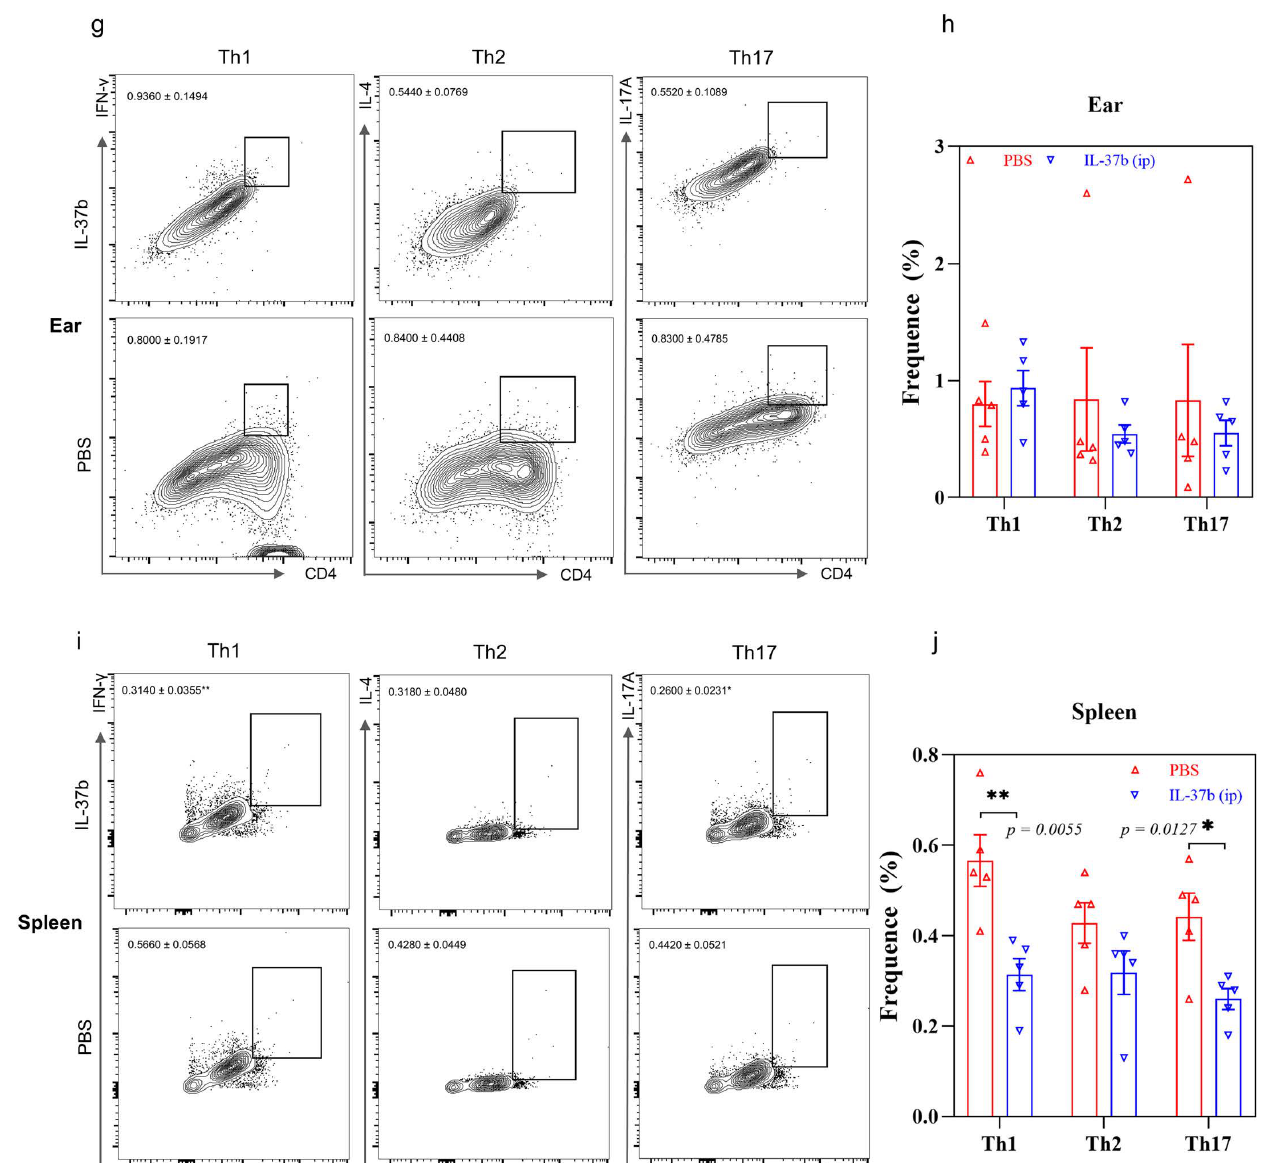
Figure 6. Effects of IL-37b injection on AD. ( a ) AD murine model schedule; ( b ) ear swelling, skin moisture and scratching times; ( c ) flow cytometry analysis of basophil, eosinophil and mast cell population in ear tissue; ( d ) quantitative analysis of result in ( c ); ( e ) flow cytometry analysis of basophil, eosinophil and mast cell population in the spleen; ( f ) quantitative analysis of result in ( e ); ( g ) flow cytometry analysis Th1, Th2 and Th17 cell population in ear tissue; ( h ) quantitative analysis of result in ( g ); ( i ) flow cytometry analysis Th1, Th2 and Th17 cell population in the spleen; ( j ) quantitative analysis of result in ( i ). Bar charts are shown as mean ± SEM of n = 4 or 5. * p < 0.05 and ** p < 0.01 when compared between the